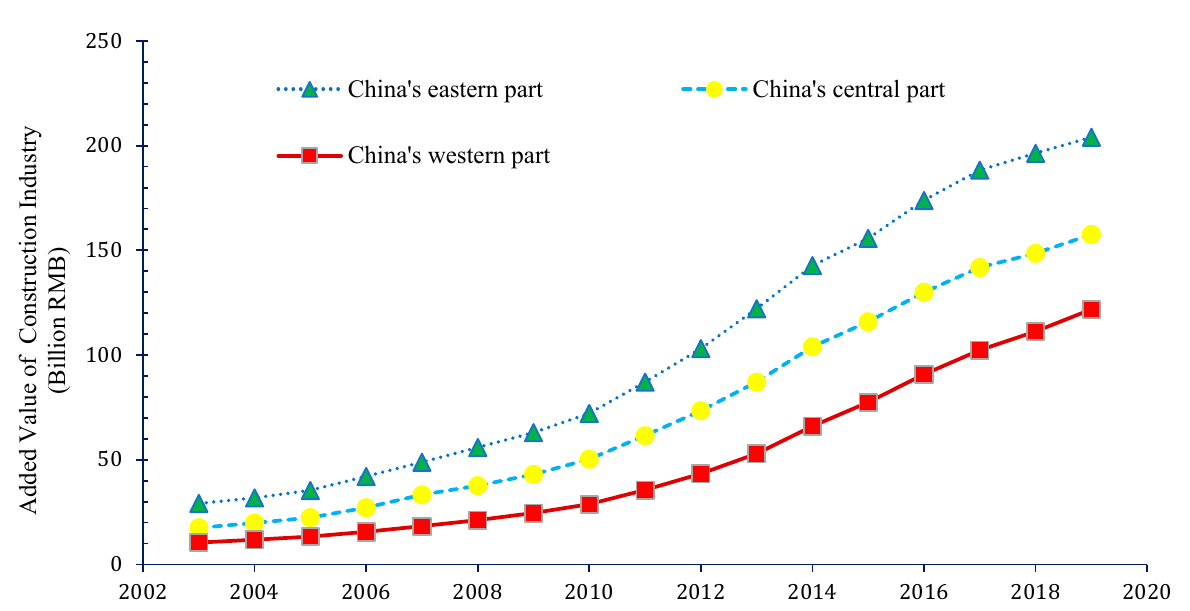
Figure 3. Outlining average trends of the added value of the construction industry across three parts of the Chinese economy. Source: Authors’ calculations based on China Statistical Yearbooks (2003– 2019).